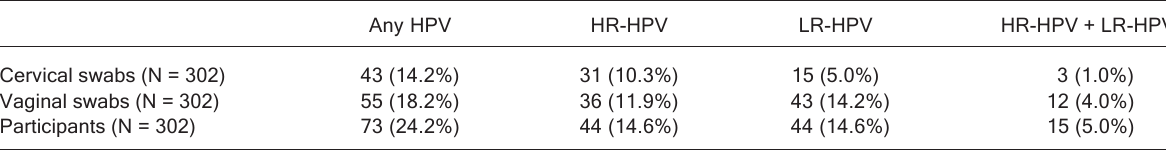
Table 1. Detection of human papillomavirus (HPV) in cervical and vaginal swabs and in